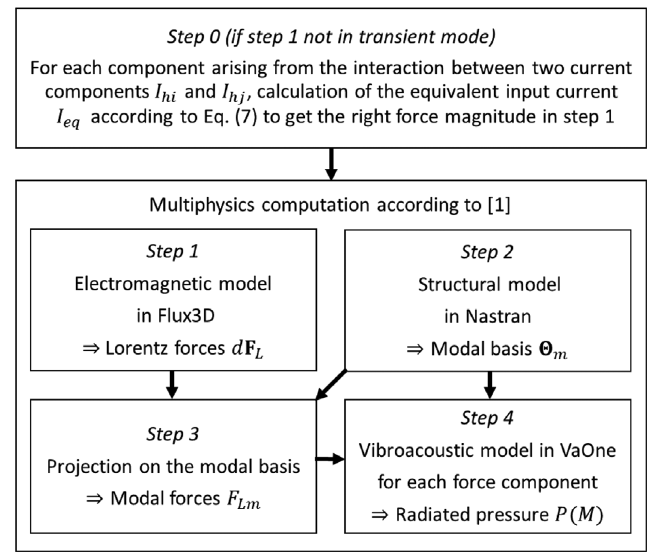
Figure 3. Computation process for a multi-components input current.